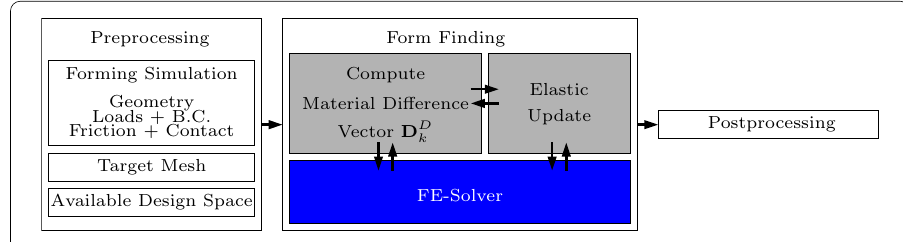
Fig. 4 Schematic representation of the optimization